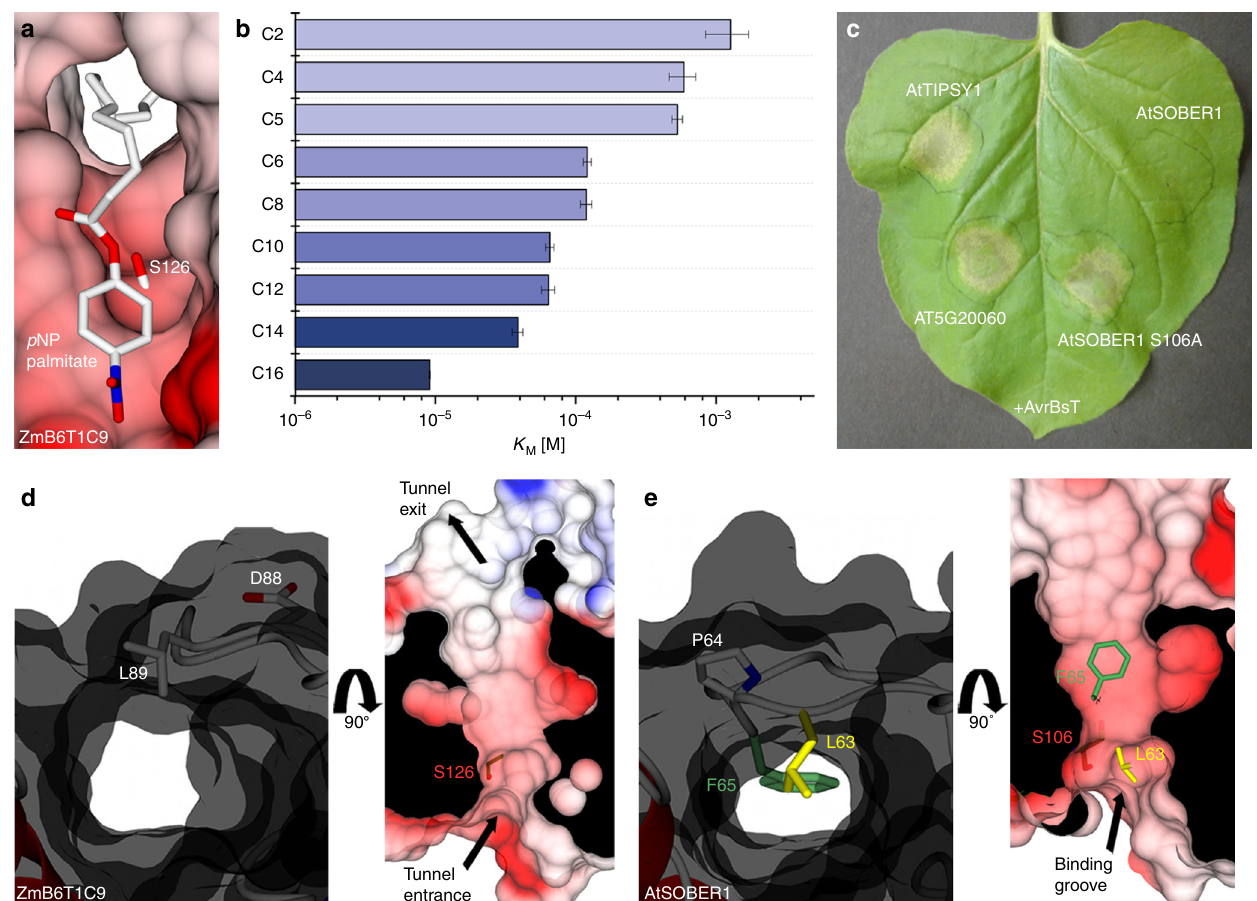
Fig. 2 ZmB6T1C9 has an open substrate tunnel while the tunnel of SOBER1 is blocked. a Tunnel architecture of ZmB6T1C9 with docked p NP-palmitate, displaying the continuous tunnel through the protein and the position of catalytic serine S126. b K M values of different para -nitrophenyl esters from p NP acetate (C2) through p NP-palmitate (C16) to ZmB6T1C9/ZmAPT2. Data were measured in triplicates and error bars indicate standard deviation. c Transient co-expression of AtSOBER1 (wild type and enzymatic dead mutant), AtTIPSY1 and AT5G20060 (closest Arabidopsis homolog of ZmB6T1C9) with avrBsT in N. benthamiana . d Open tunnel architecture in ZmB6T1C9. e Blocked tunnel architecture in AtSOBER1 and location of tunnel blocking